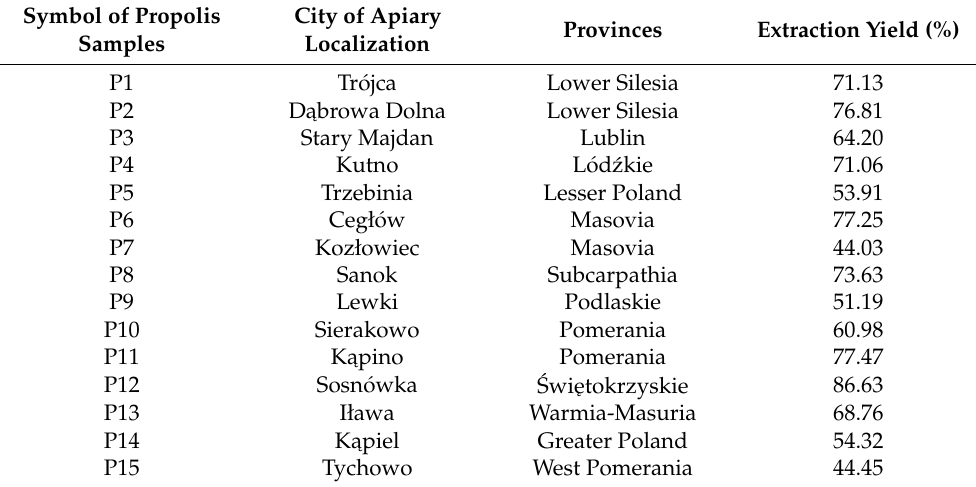
Table 3. The locations of apiaries from which propolis was collected and the yields of extraction